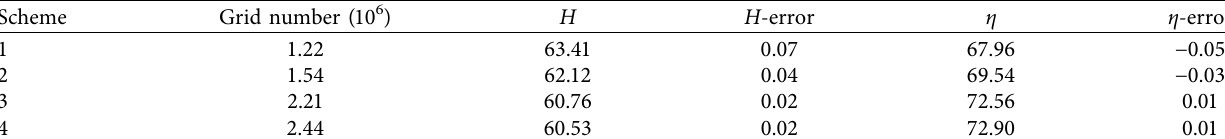
Table 1: Verification of grid independence.